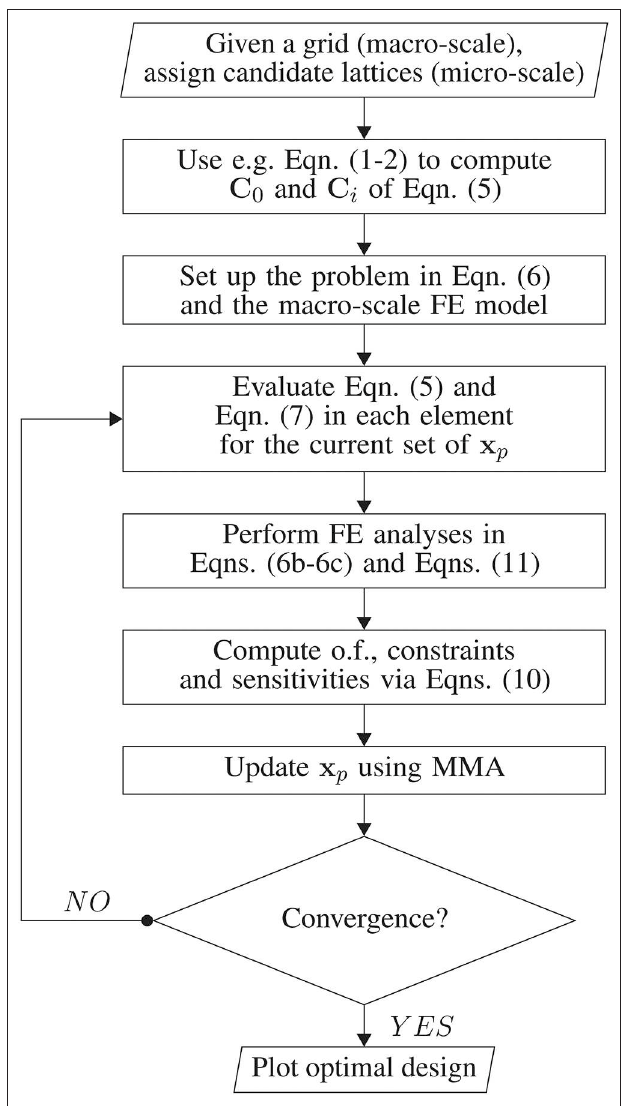
FIGURE 2 | Flowchart of the proposed tool.